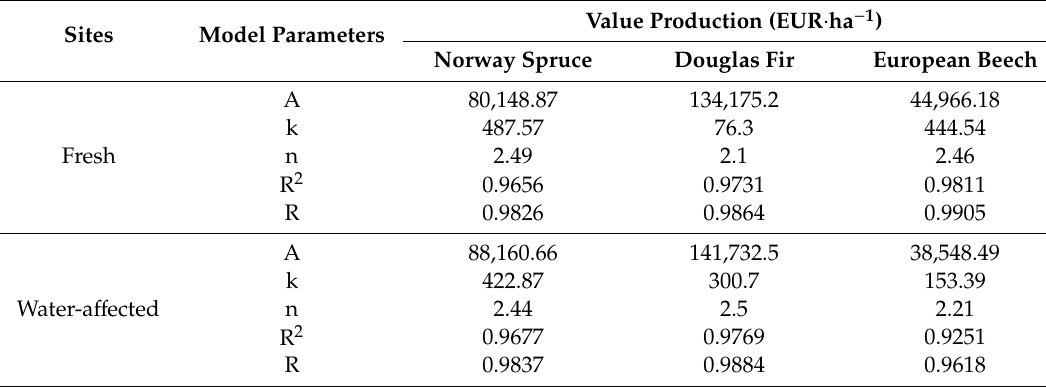
Figure 3. Model course of value production together with real values in fresh sites. Table 3. Parameters of Korf’s growth model for value